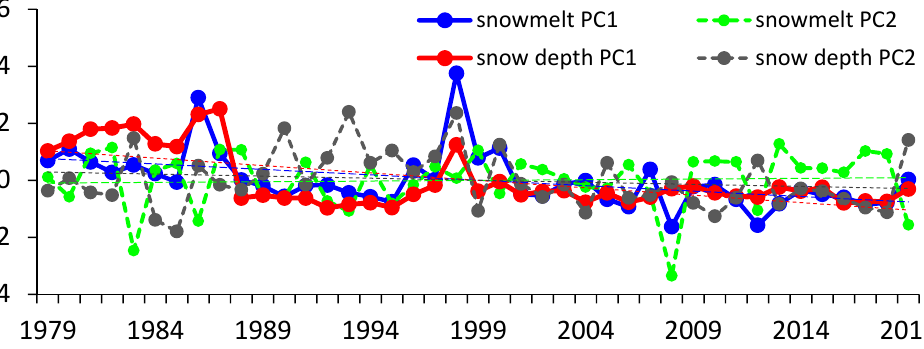
Figure 3. Principal components (PCs) of the first and second EOF modes of the spring snowmelt and snow depth over the TP.